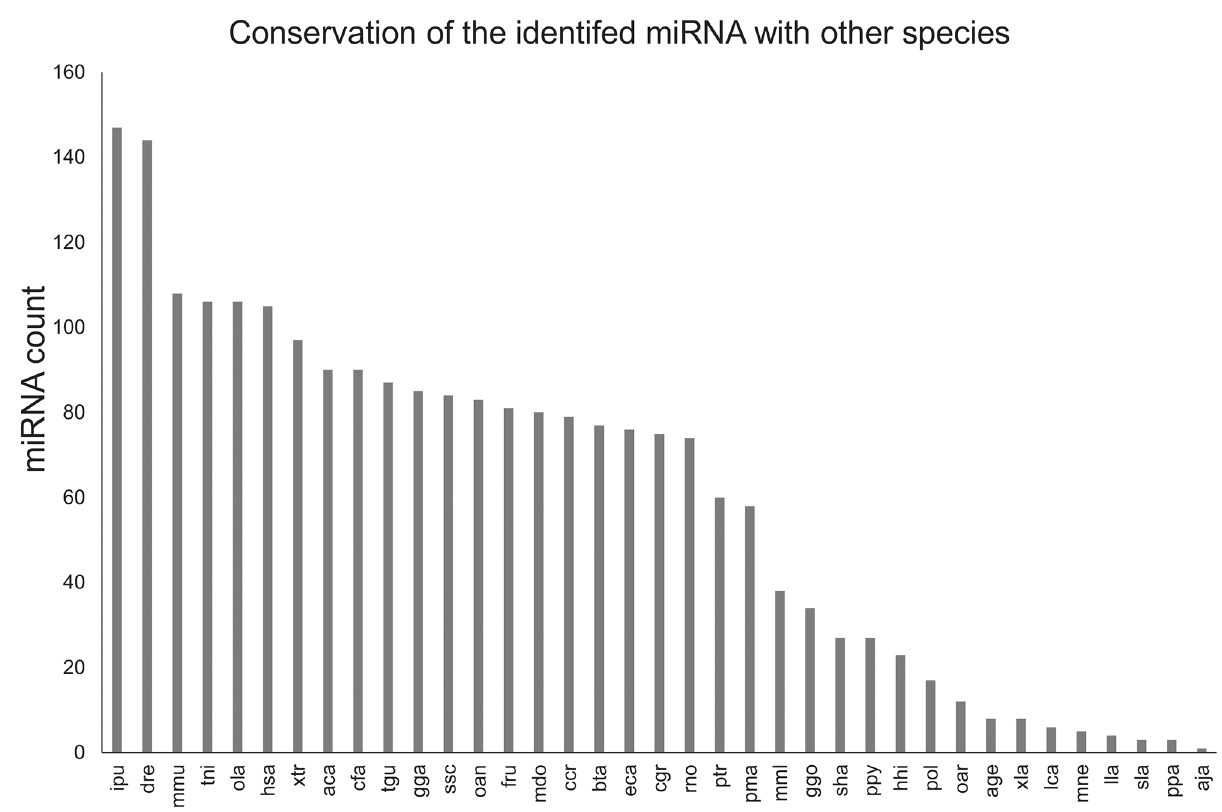
Fig 5. Conservation profile of the identified miRNA. The frequency of identified miRNAs is calculatedby mappingwith 37 species (horizontalaxis) in miRbase, and the miRNA counts are shown on the vertical axis.